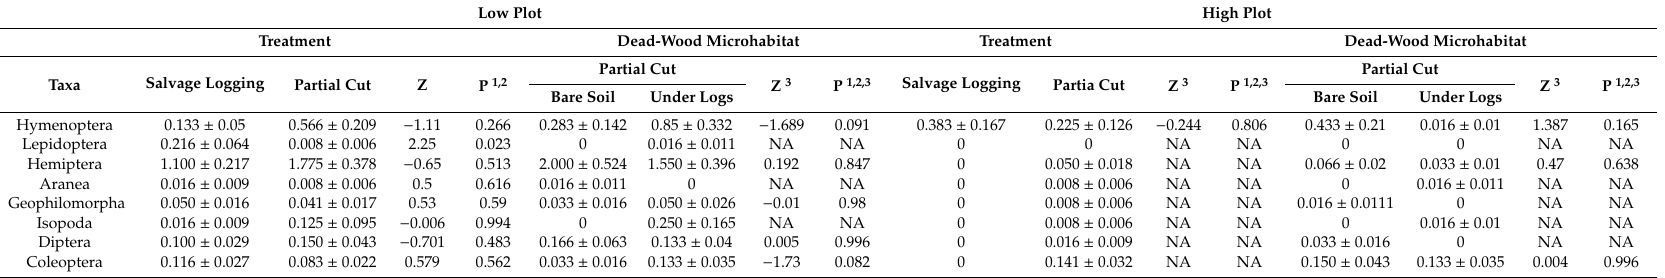
Table 4. Mean abundance (number of individuals / sample ± 1 S.E. of the mean) of the main macroarthropod taxa across treatments and microhabitats. Low Plot High Plot Treatment Dead-Wood Microhabitat Treatment Dead-Wood